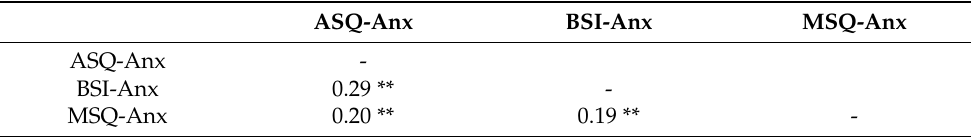
Table 3. Correlations between the main variables of the study.